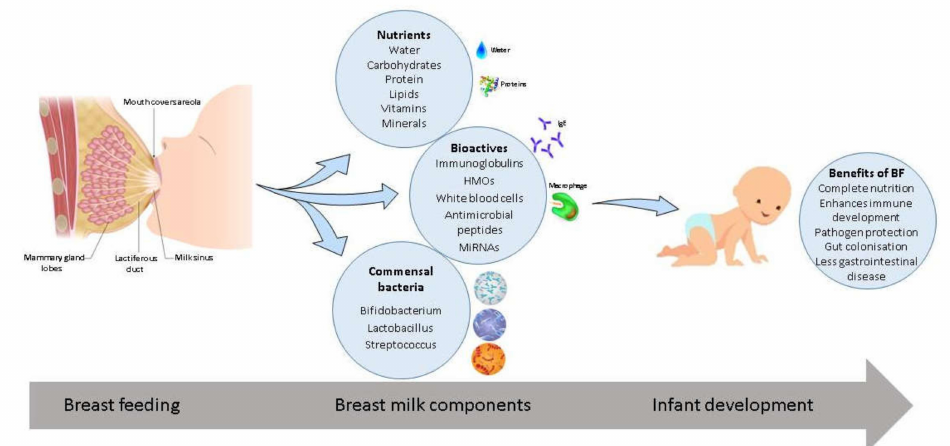
Figure 1. Breast milk composition and associated benefits. Breast milk provides essential nutrients, bioactive compounds, and commensal bacteria which aid in growth and development of the infant and the immune system. Associated benefits of breast feeding (BF) include protection against pathogens, enhanced immune development, complete nutrition, promotion of gut colonization, and less incidences of gastrointestinal